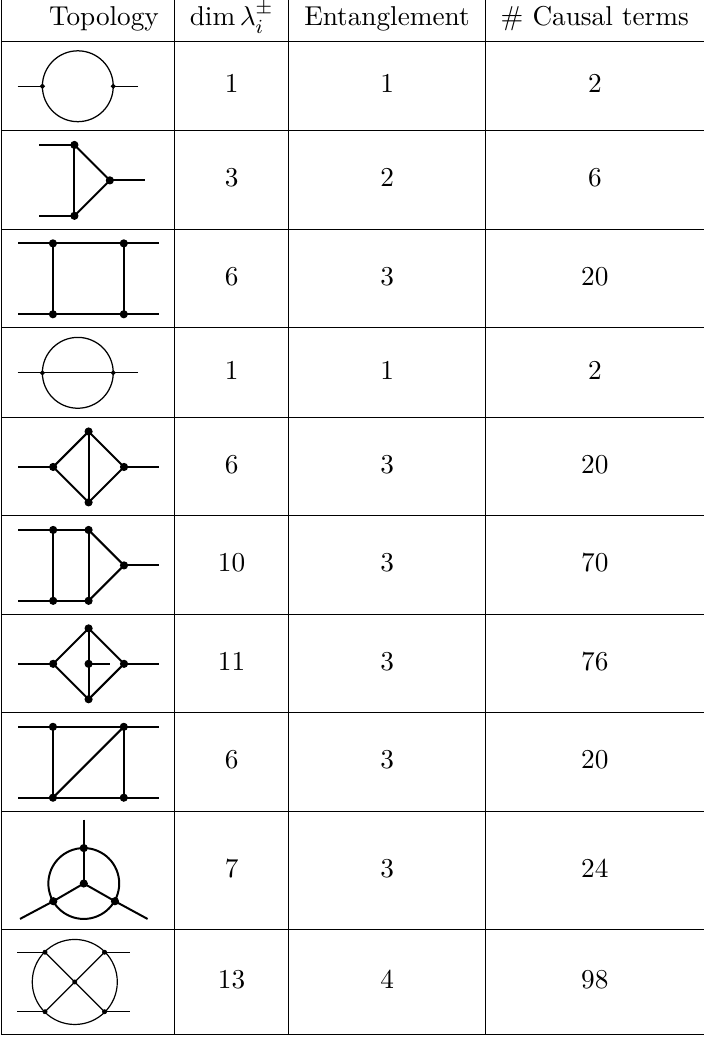
Table 1 . Selected topologies generated from the causal representation of the N 3 MLT configuration by applying the removing and collapsing